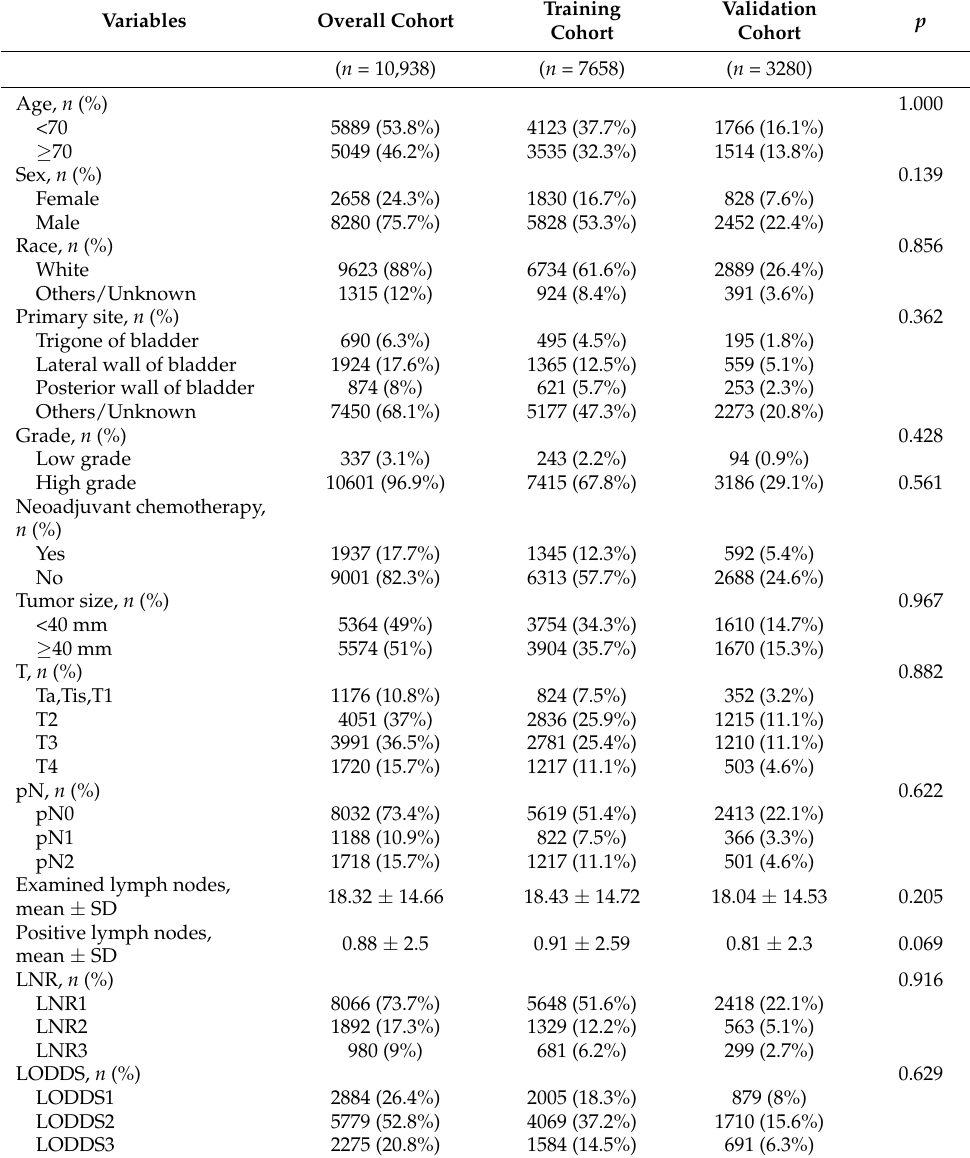
Table 1. Clinical and pathological